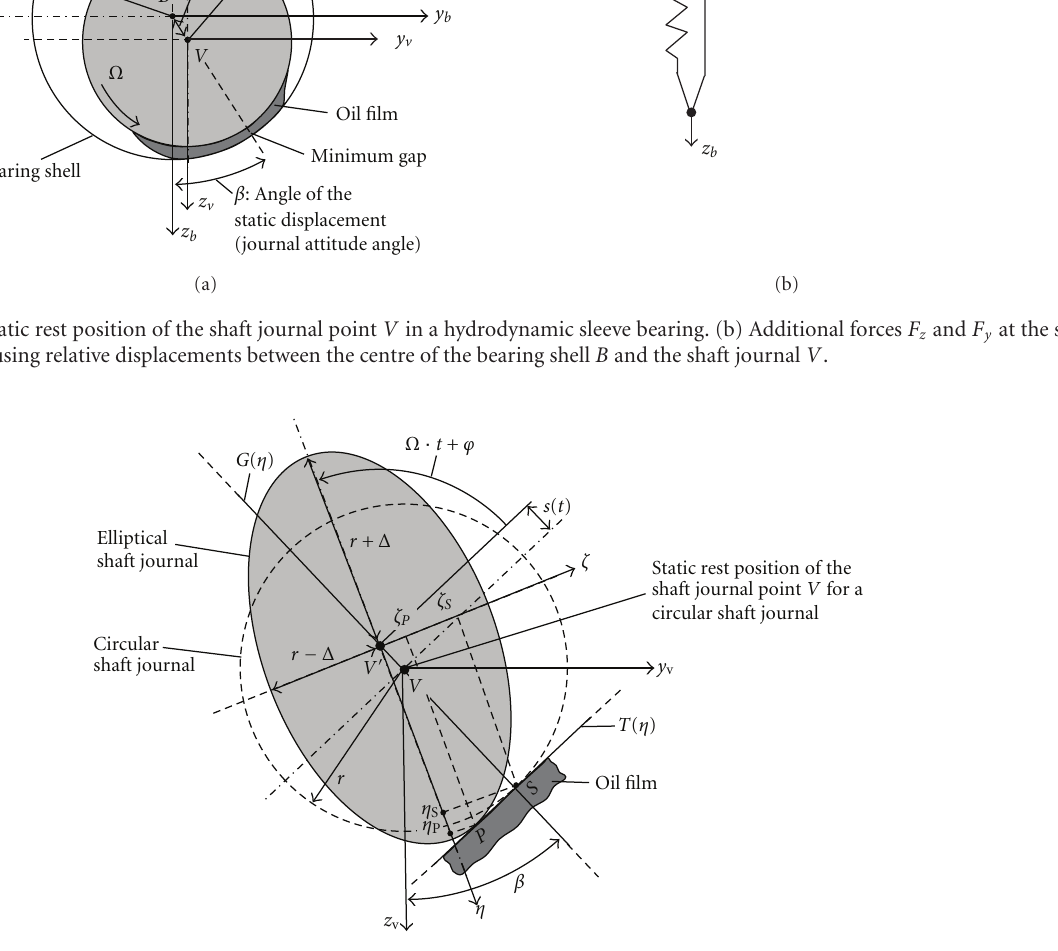
Figure 3: Forced displacement s ( t ) of the shaft journal point V on an oil film due to the rotation of an elliptical shaft journal.